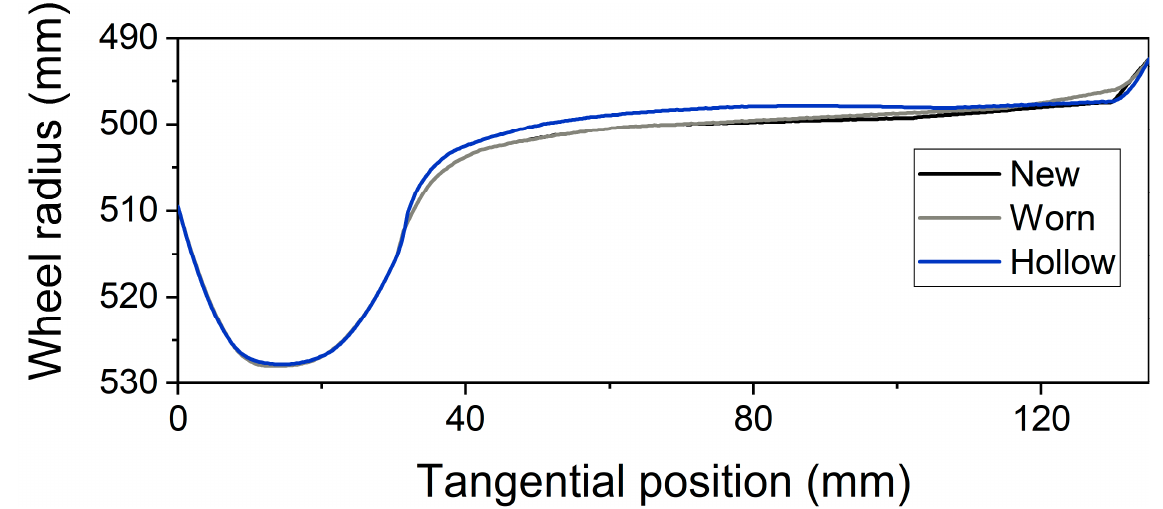
Figure 10. Unworn and worn profiles of the standard profile ORE S1002 considered in the FEA.